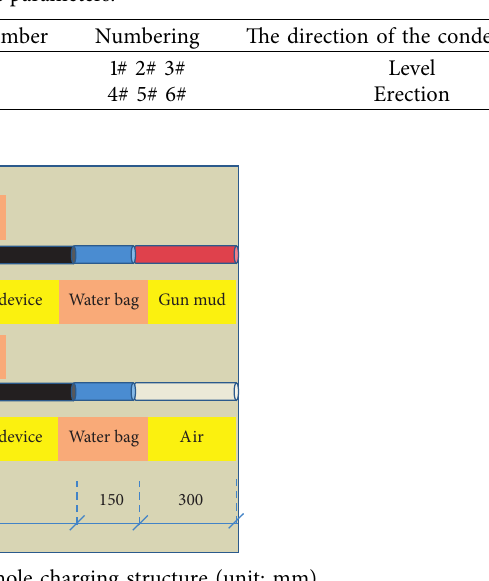
Table 1: Blasting test parameters.